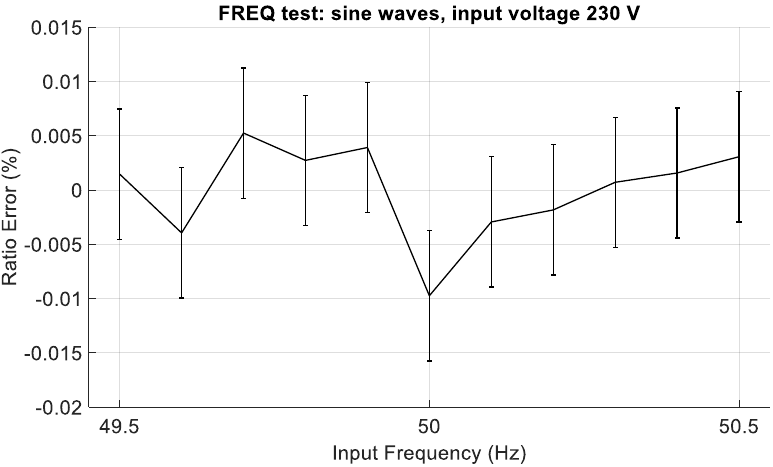
Figure 15. Ratio error in the FREQ tests, with sinusoidal input voltage with amplitude of 230 V and frequencies from 49.5 Hz to 50.5 Hz.